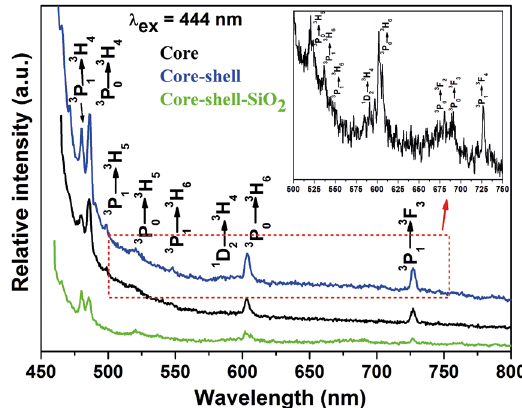
Figure 7. Emission spectra of the core, core-shell and core-shell- SiO microspheres. 2